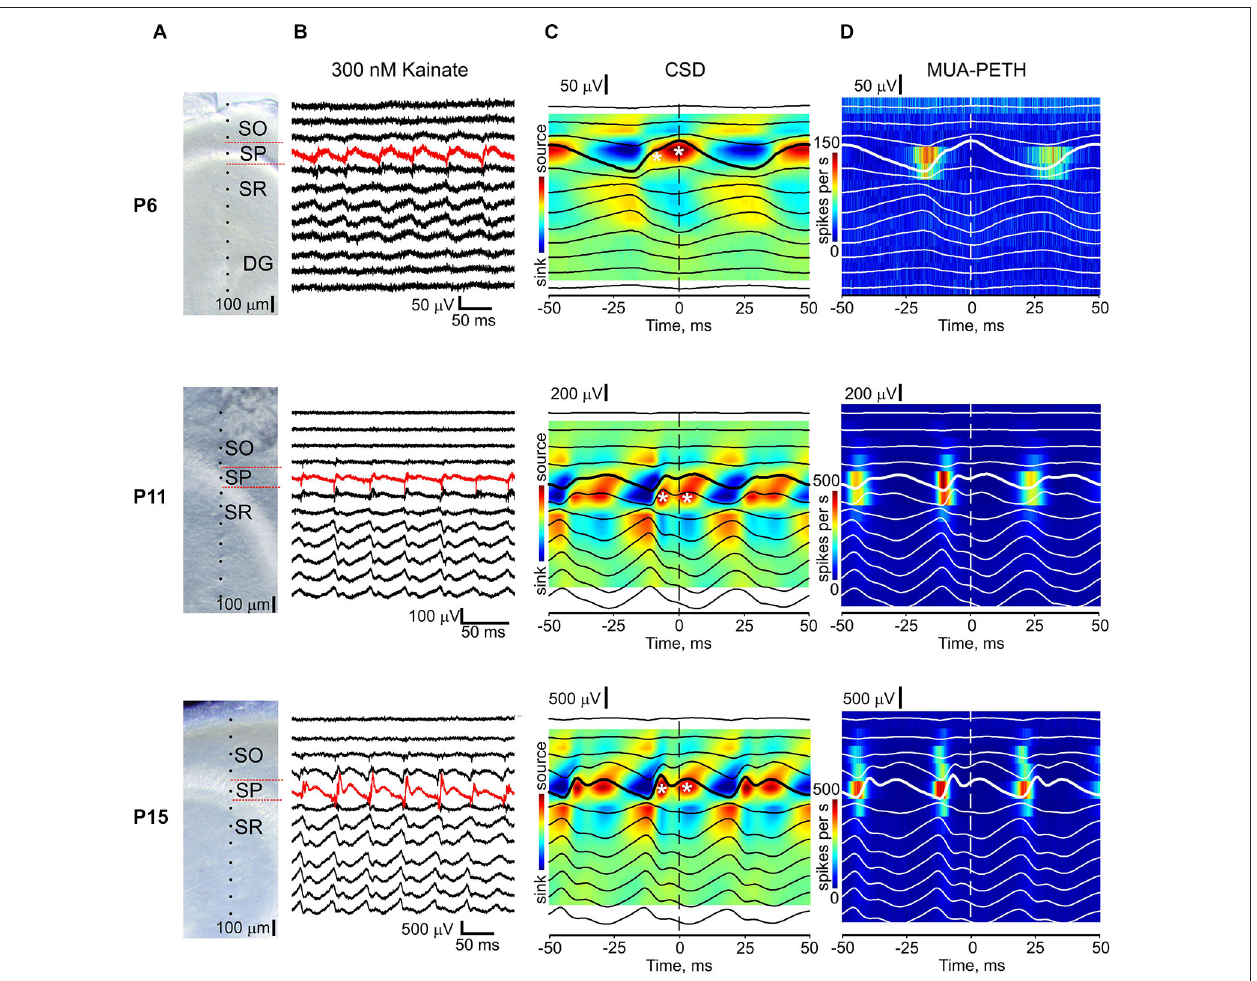
CA3 pyramidal cell layer. (C) , KA-Os’ peak triggered average LFP (black traces, bold signal is from CA3 pyramidal cell layer) overlaid on CSD of KA-Os. Time = 0 corresponds to the KA-Os’ peak. White asterisks indicate two sources associated with the peaks of KA-Os at the pyramidal cell layer. (D) KA-Os’ peak triggered average MUA peri-event time histograms. (C,D) average of 2090 (P6), 18163 (P11) and 6282 (P15) KA-O